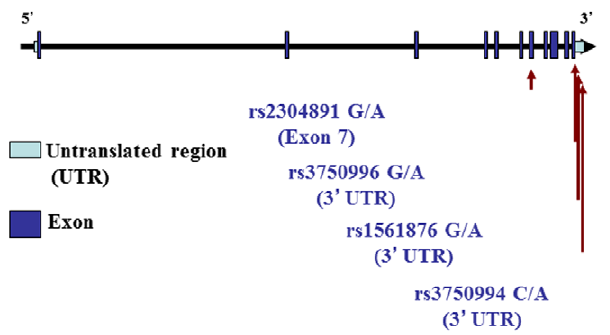
Figure 1. Graphical overview of the genotyped human STIM1 gene polymorphisms in relation to its exon/intron structure.